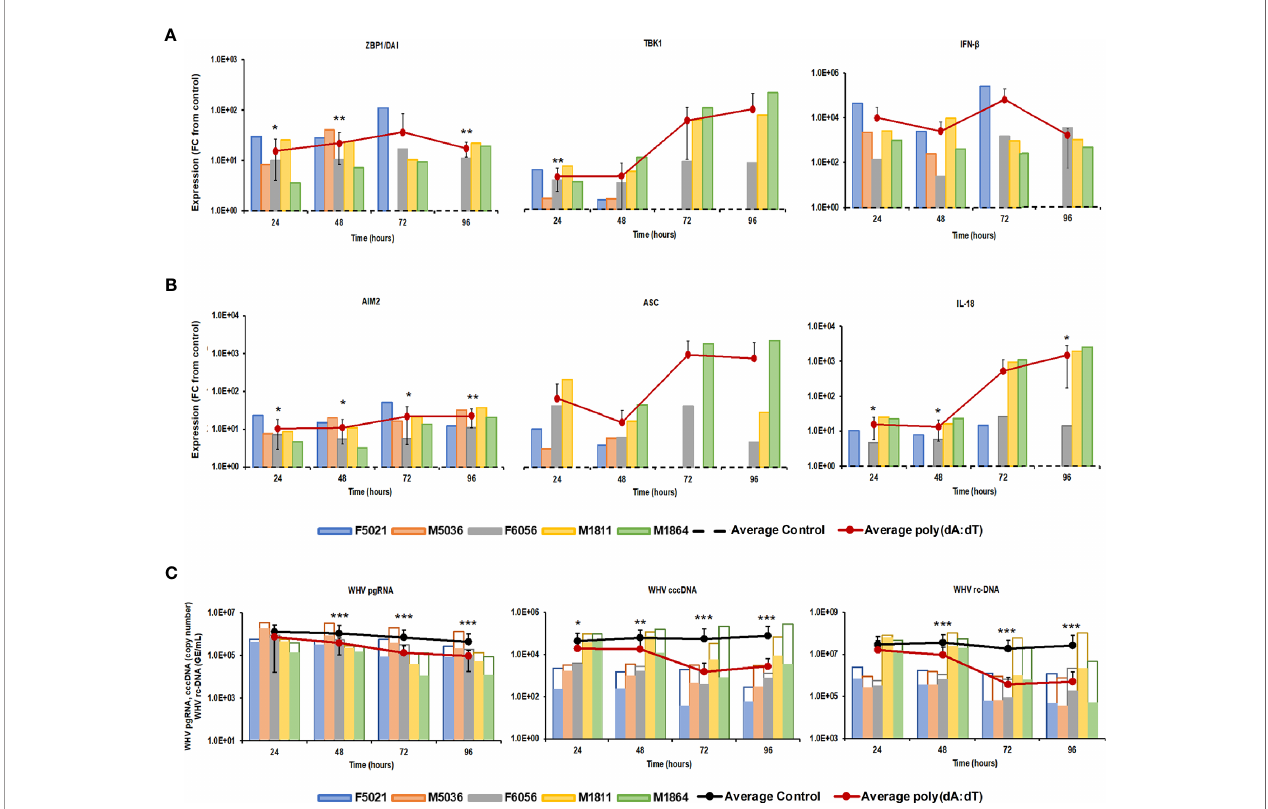
FIGURE 2 | Agonistic activation of ZBP1/DAI and AIM2 receptor pathways mediates WHV suppression. PWHs generated from the liver of fi ve woodchucks with CHB were treated with poly(dA:dT) at T0 and again at 48 hours. The fold-changes in transcript level of (A) ZBP1/DAI, TBK1, and IFN- b and (B) AIM2, ASC, and IL- 18 over 96 hours are shown, when compared to their transcript level in untreated control PWHs from individual animals at each timepoint, which was set at 1.0 and is indicated by the dotted line. (C) The changes in WHV replication (pgRNA and cccDNA) and secretion (rc-DNA) during treatment are presented for untreated control (empty bars) and poly(dA:dT)-treated PWHs (colored bars) from individual animals at each timepoint. The average fold-change in gene transcript level or average change in WHV load of control and poly(dA:dT)-treated PWHs are presented as solid lines. Horizontal bars represent the standard error of the mean. P values representing statistical signi fi cance from untreated control PWHs are shown as * for <0.05, ** for <0.01, and *** for <0.001. FC,